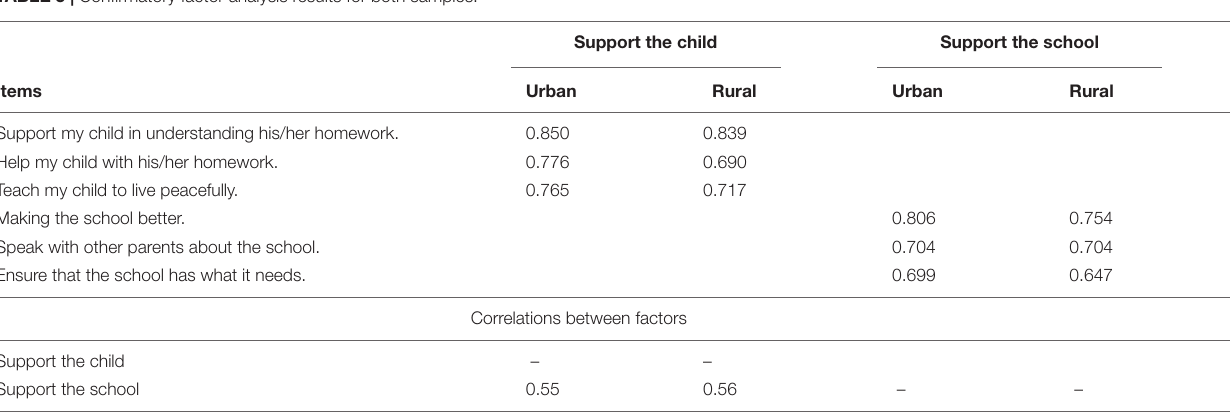
TABLE 5 | Confirmatory factor analysis results for both samples.